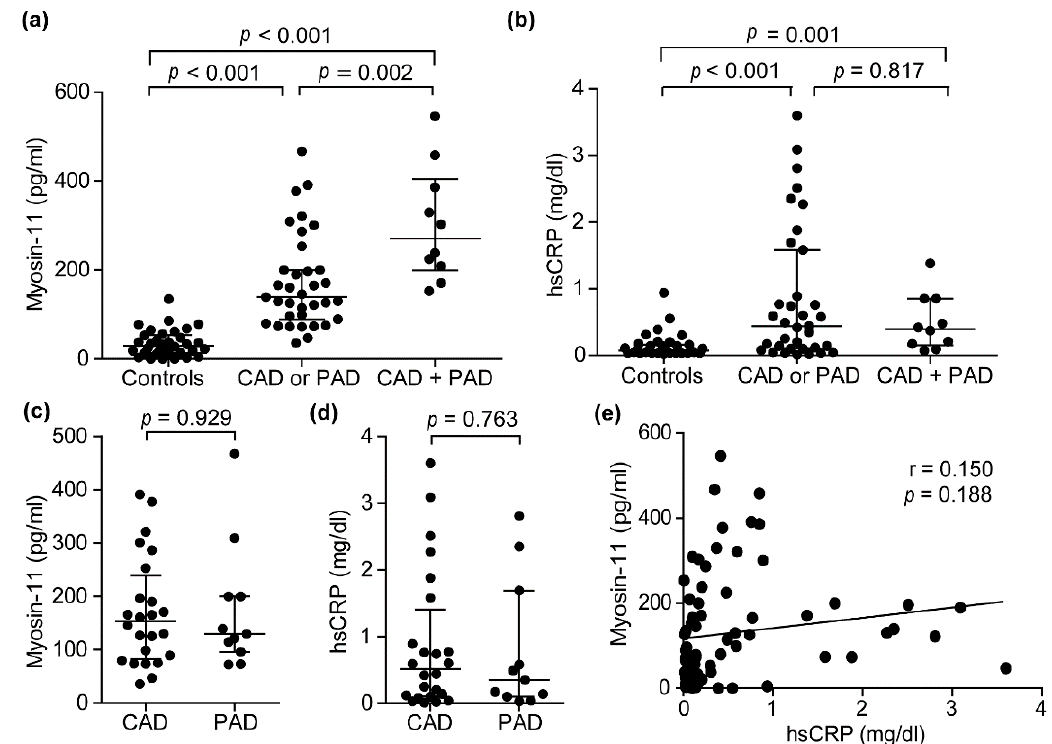
Figure 1. Plasma myosin-11 (myosin heavy chain 11) levels in patients with atherosclerosis. ( a , b ) Myosin-11 and hsCRP (high-sensitivity C-reactive protein) concentrations in plasma samples of control subjects (Controls, n = 34), patients with CAD (coronary artery disease) or PAD (peripheral artery disease) (CAD or PAD, n = 35), and patients with both CAD and PAD (CAD + PAD, n = 11). Data are shown as the median with interquartile ranges. ( c , d ) Myosin-11 and hsCRP concentrations in plasma samples from CAD ( n = 24) and PAD ( n = 11) patients. Data are shown as the median with interquartile ranges. ( e ) Correlation between plasma concentrations of myosin-11 and hsCRP in all patients and controls ( n = 80).